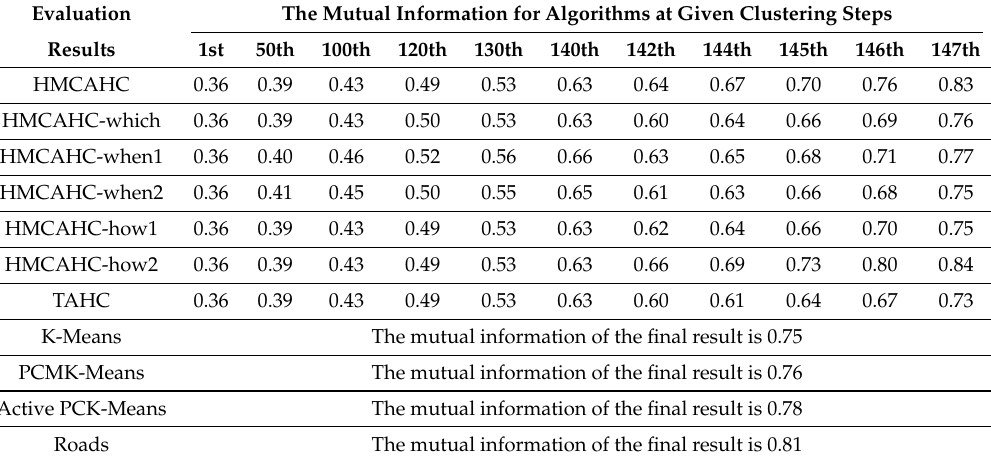
Table 1. Mutual information for the Iris Flower Data Set.